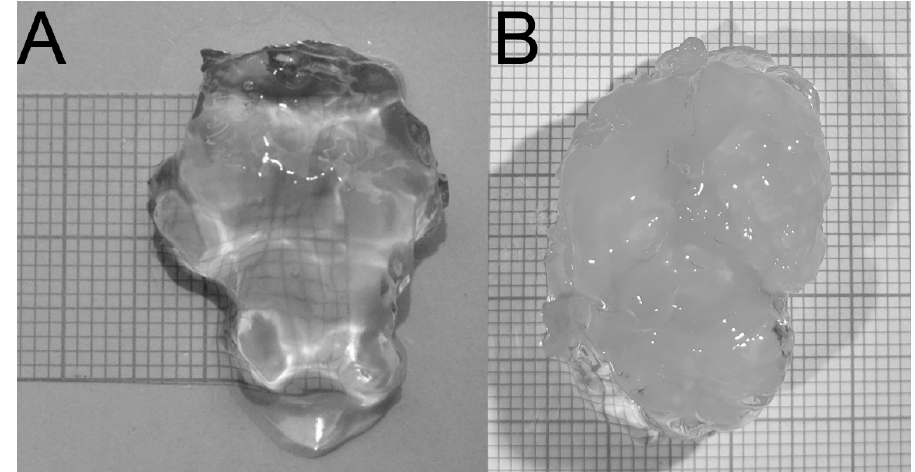
Figure 4. Comparison of CLARITY processed rat brains after 24 hours. ( A ) Transparent hydrogel of rat brain by adapted CLARITY apparatus. ( B ) Original designed CLARITY apparatus (courtesy of Charles University, Prague, Czech Republic). The millimeter grids are attached in the background.